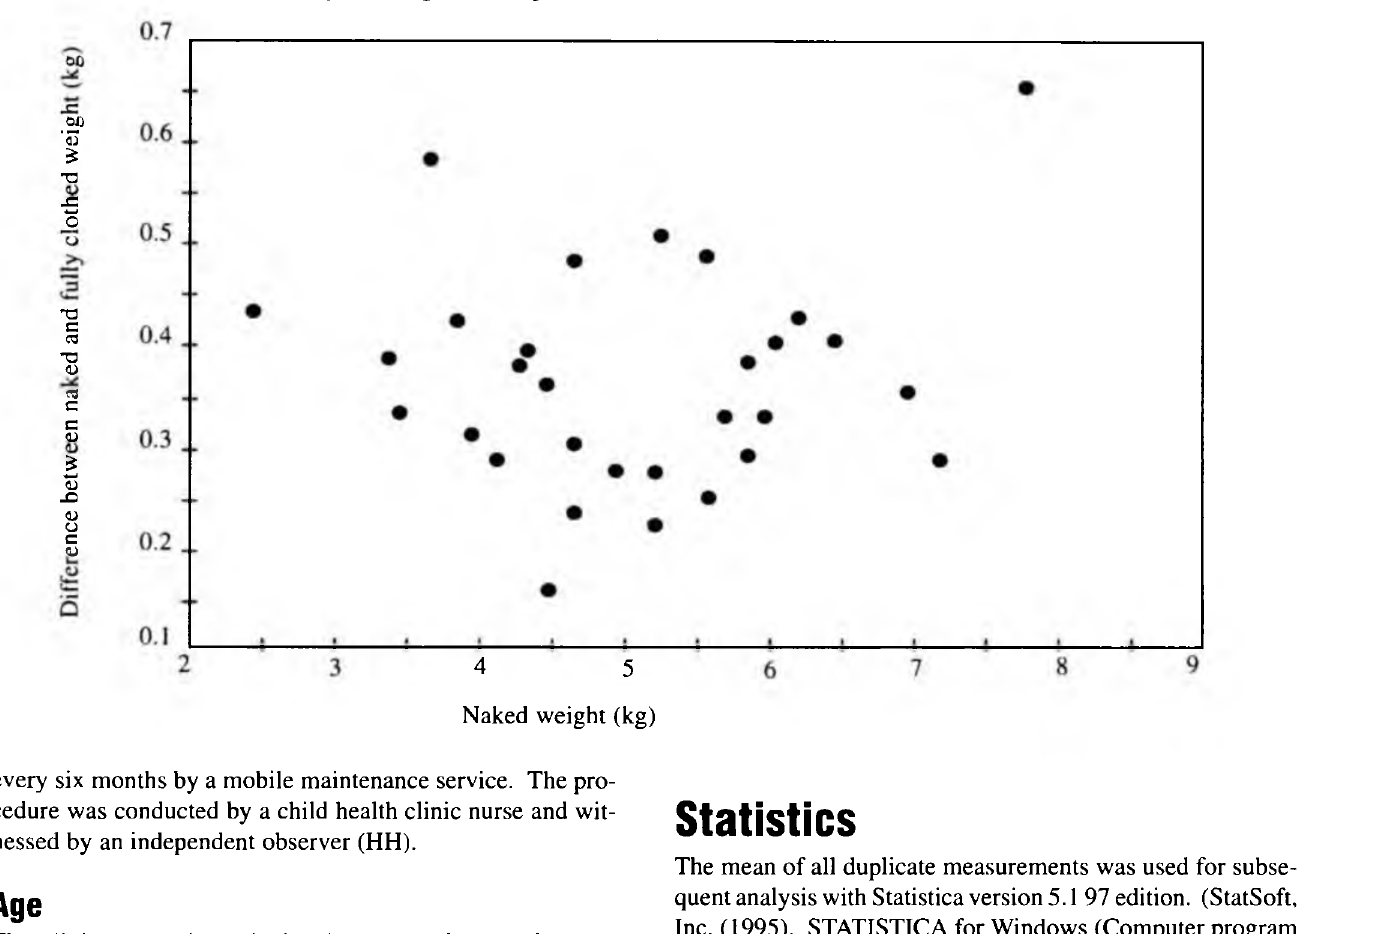
Figure 3 Error if baby is weighed in a